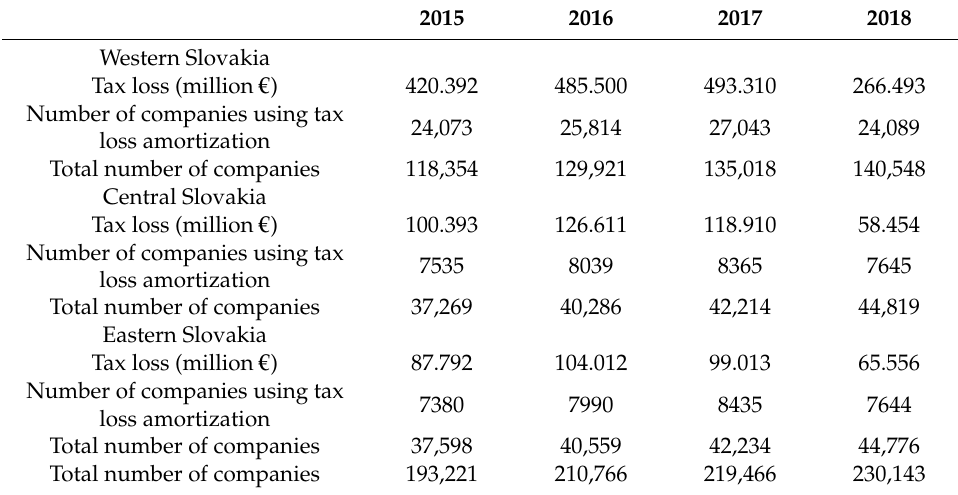
Table 5. The data characterizing the tax situation of the companies from 2015 to